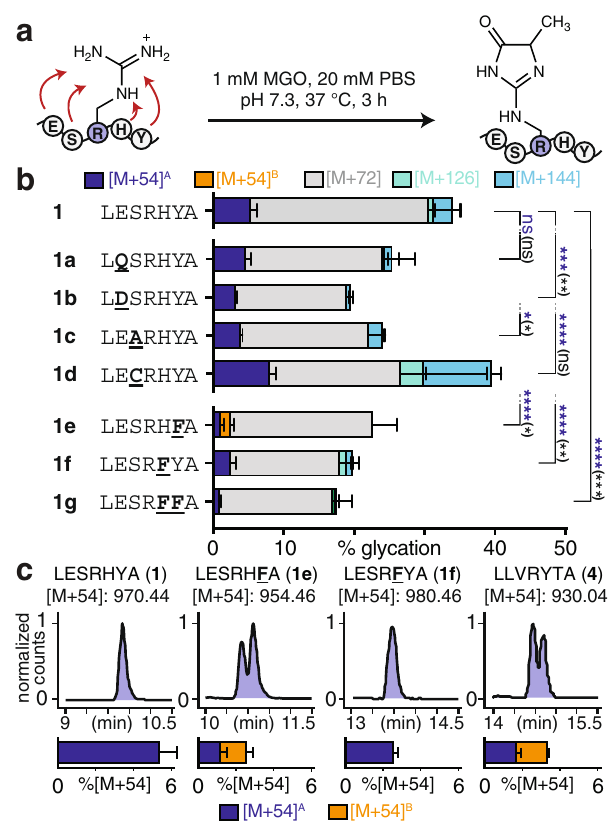
Fig. 3 Tyrosine is essential to bias a single MGH isomer. a To determine how each residue within the hit sequence contributes to glycation, point variants of peptide 1 were evaluated by LC-MS following in vitro glycation. Puri fi ed, N-terminally acetylated, synthetic peptides (peptides 1a – g ) were allowed to react with equimolar MGO (1 mM) in pH 7.3 PBS for 3 h at 37 °C. b Distribution of glycation adducts observed for variants of peptide 1 ( 1 , n = 8; 1a – 1g , n = 3). Stacked bar graphs are plotted as mean ± standard deviation for each mass adduct. Individual data points are shown in Supplementary Fig. 9. Adduct legend: blue, [M + 54] A ; orange, [M + 54] B ; gray, [M + 72]; green, [M + 126]; cyan, [M + 144]. In general, substitutions made on the C-terminal peptide fl ank resulted in the greatest reduction in [M + 54] and total glycation levels. A nondirectional (two- tailed) one-way ANOVA using Dunnett ’ s multiple comparison test was used to determine if each variant yielded statistically signi fi cant differences in [M + 54] (blue) or total glycation (black) levels compared to peptide 1 . p < 0.05(*), p < 0.01(**), p < 0.001(***), p < 0.0001(****). See also Supplementary Fig. 10. c Representative extracted compound chromatograms (ECCs) for [M + 54] adducts reveal that a substitution in place of Tyr (peptide 1e ), but not His (peptide 1f ) results in the formation of multiple [M + 54] isomers (i.e., MGH isomers). Multiple isomeric [M + 54] products were also observed for a control sequence derived from HSA (peptide 4 ), and for scrambled variants of peptide 1 (Supplementary Fig. 13). These results suggest that the speci fi c placement of Tyr in peptide 1 is critical for the formation of a single [M + 54] product. Source data are provided as a Source Data fi le. Additional statistical information, including exact p -values, is available in an additional Supplementary Data fi